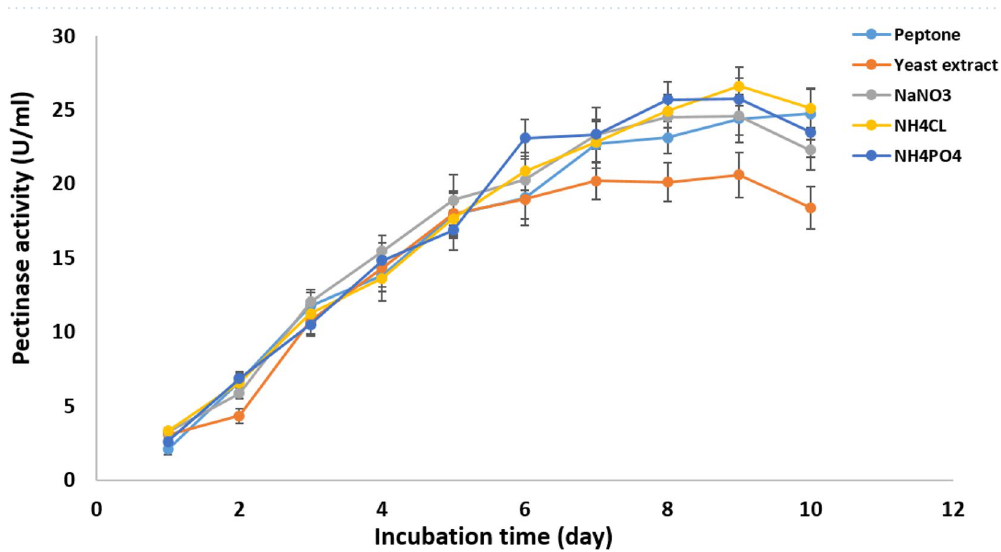
Figure 11. Effect of nitrogen source and incubation time on the pectinase production by C. chlamydosporigenum AUMC 11340 at pH 5.0 and 10 °C after 9